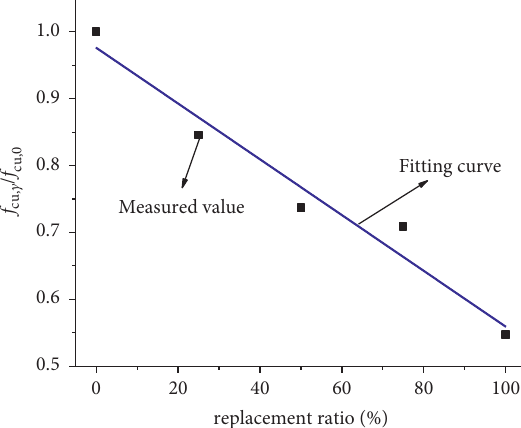
Figure 6: Fitting curve of f cu, c / f cu,0 and replacement ratio.